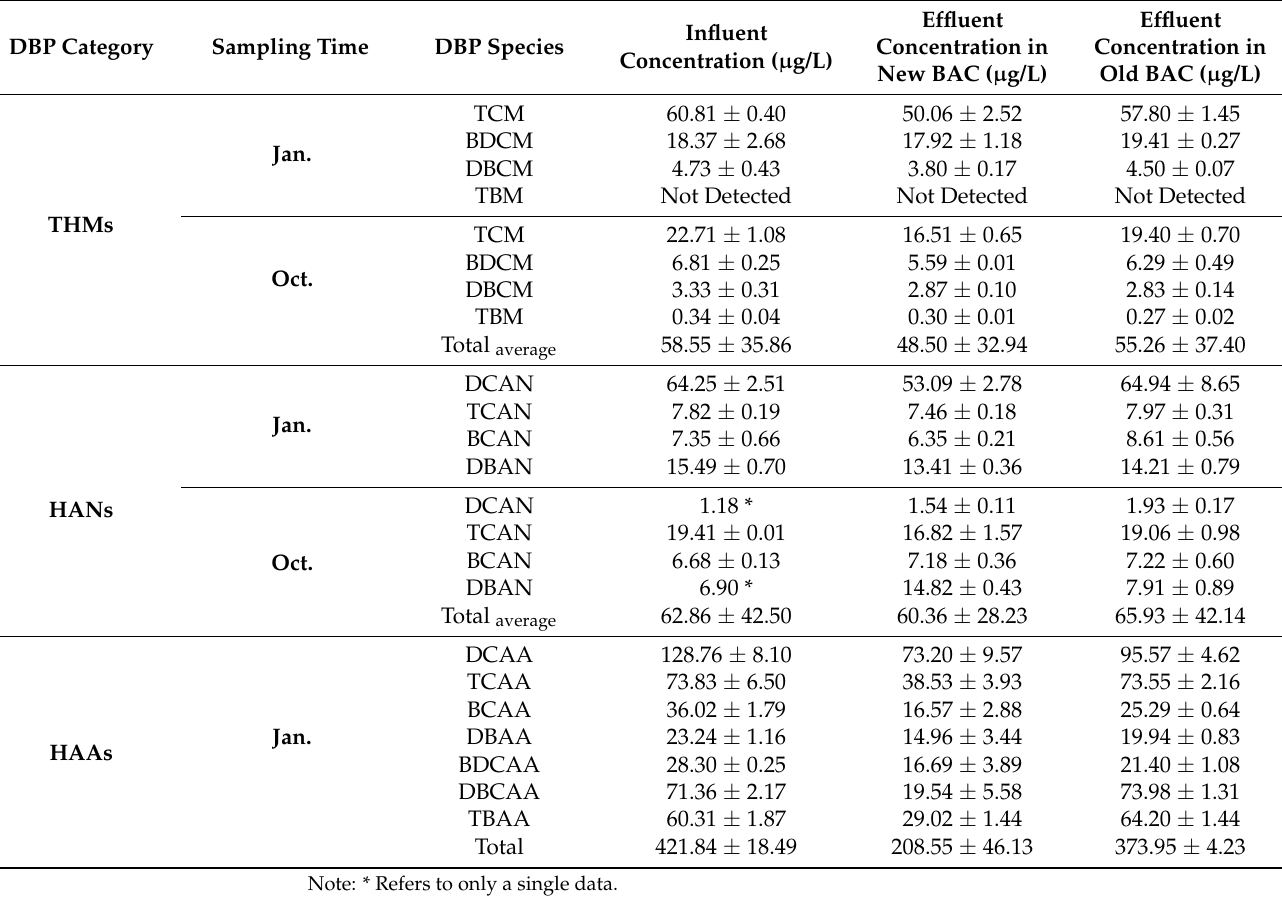
Table 4. Formation potential of THMs, HAAs, and HANs during chlorination of the influent and the effluent of old and new BAC filters. ( n = 3).